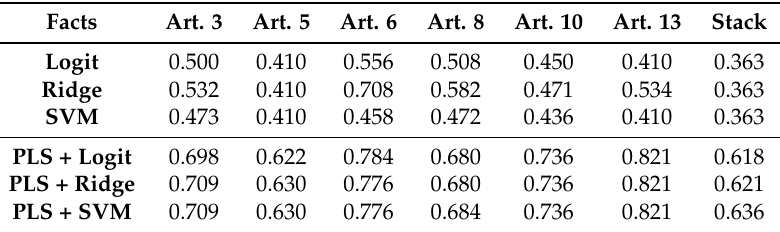
Table 7. Accuracy with tf-idf input on facts.